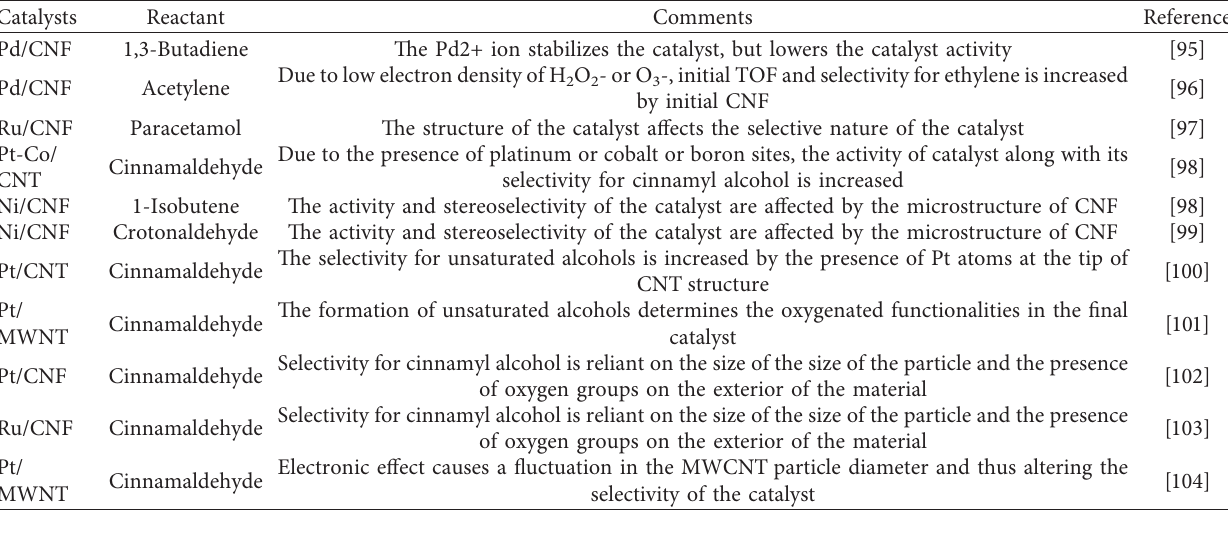
Table 6: Selective hydrogenation reactions using CNF/CNT-supported metallic catalysts.